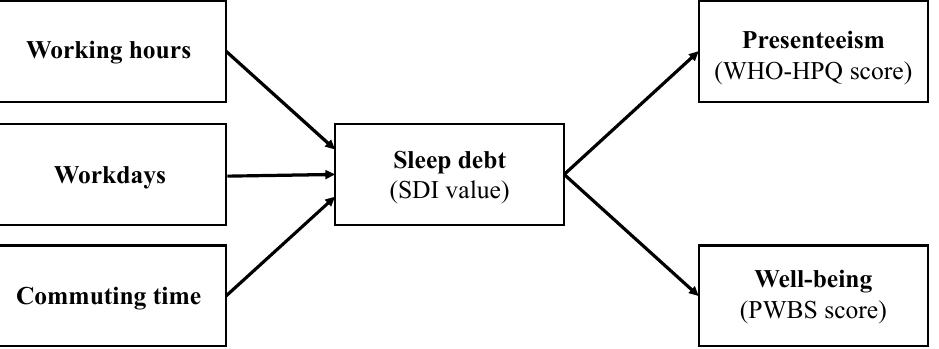
Figure 1. Hypothetical model for this study. PWBS, Psychological Well-Being Scale; SDI, Sleep Debt Index; WHO-HPQ, World Health Organization Health and Work Performance Questionnaire.